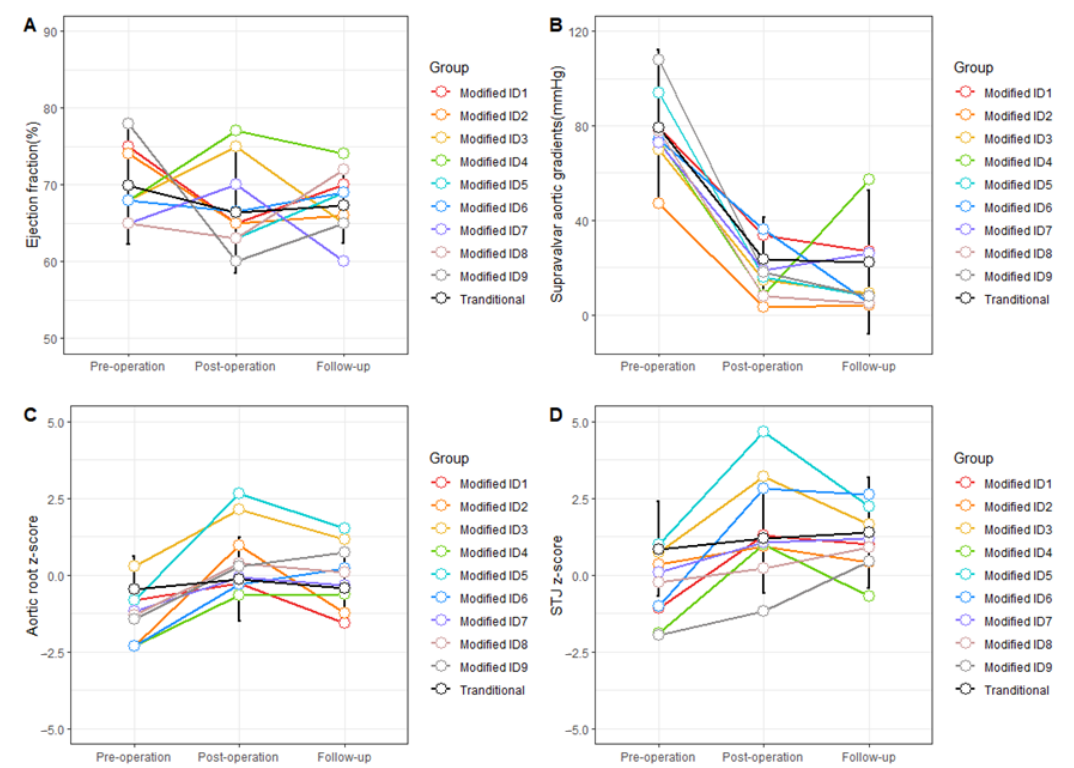
Figure 3. The information of the modified and traditional technique pre-, post-operation, and at follow-up. ( A ) Ejection fraction; ( B ) Supravalvar aortic gradients; ( C ) Aortic root z-score; ( D ) STJ z-score. The patient ID1-ID9 with the modified technique are shown in red, orange, yellow, green, cyan–blue, blue, purple, pink, and grey separately. The patient information of the traditional technique is shown in black, and the points mean the mean value, and the bar means mean ± sd. Abbreviation: STJ, sinotubular junction.